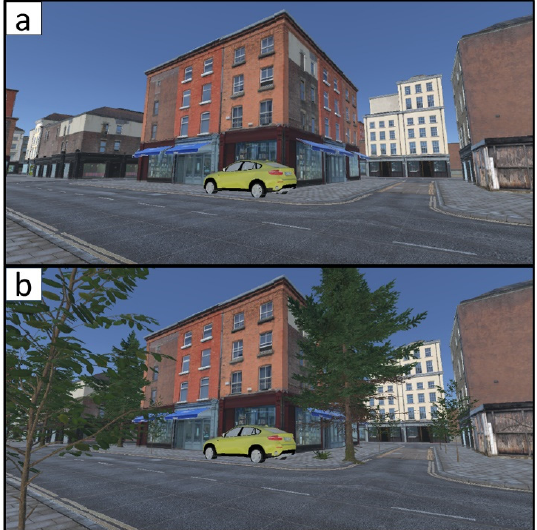
Figure 2. A 2-D view of the immersive virtual environment (IVE) extracted from near the starting point of the experiment. ( a ) control condition (no greenery); ( b ) green condition. The two environments are identical other than green elements that were used in the second environment. Pupil fixation on the yellow car that appears in the images was recorded using the VR headset’s eye-tracking sensor. Table 1. Participants’ characteristics and per-run descriptive statistics of recorded variables.